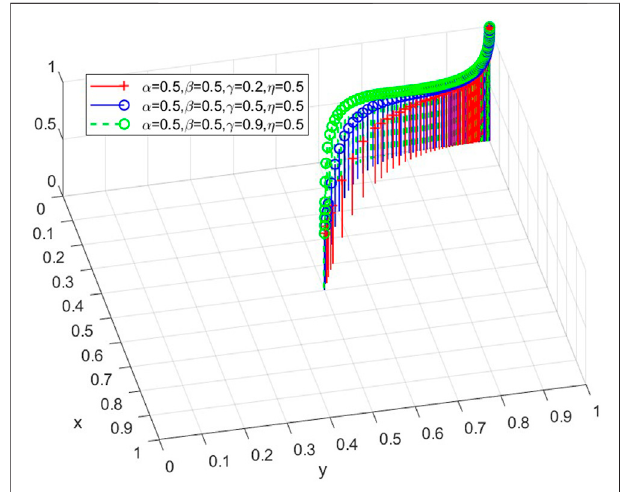
FIGURE 4 | System evolution trajectory under different subsidy intensities c